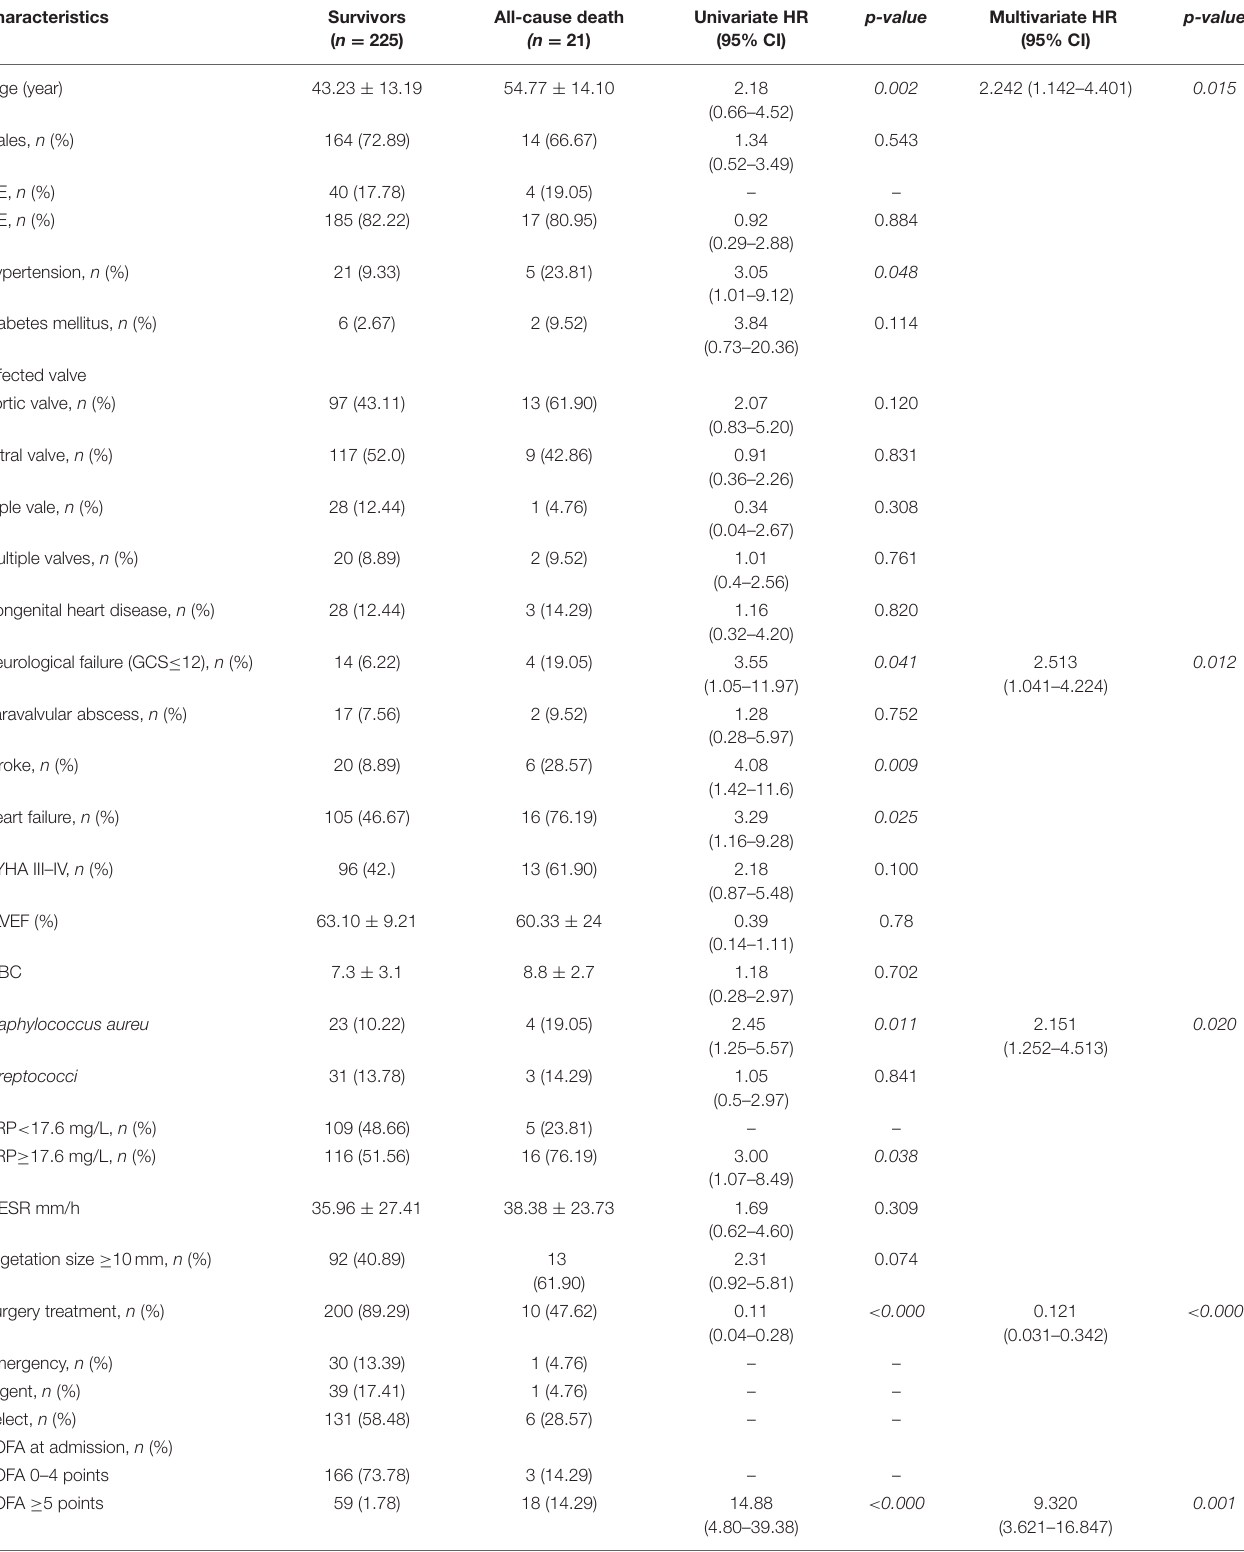
TABLE 2 | Univariate and multivariate analyses of factors associated with in-hospital mortality.